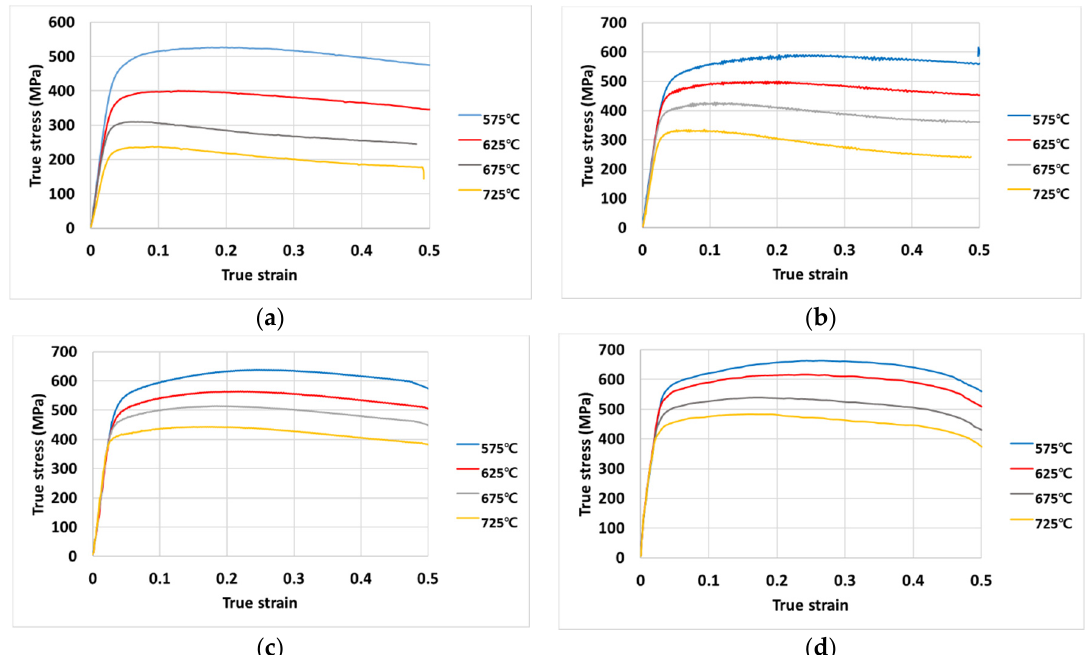
Figure 3. True stress–true strain curves at: ( a ) 0.002/s; ( b ) 0.02/s; ( c ) 2/s; ( d ) 20/s.